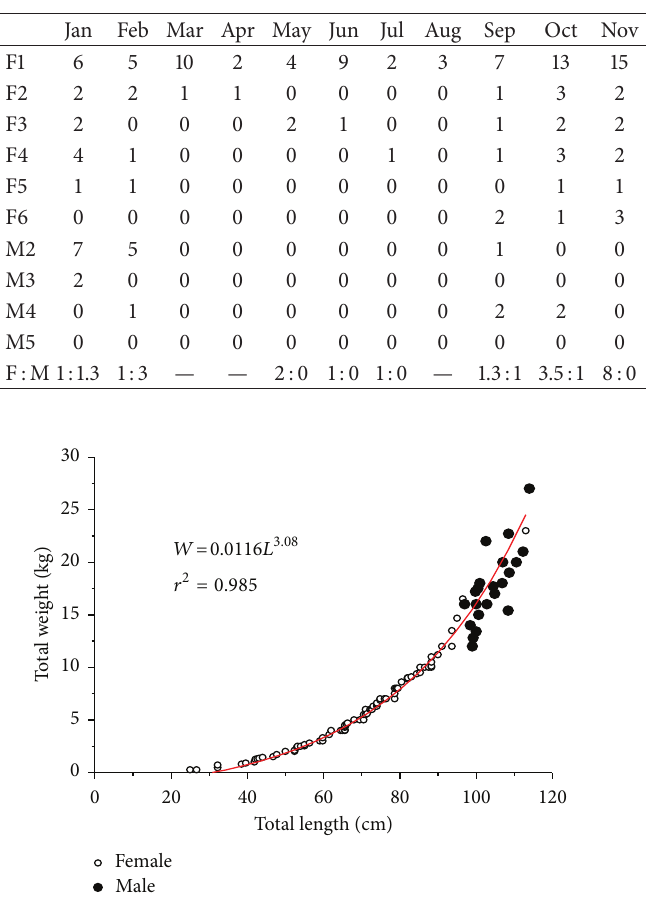
Figure 4: Length-weight relationship in Epinephelus malabaricus captured at Mafia Island between September 2009 and December 2010 ( 𝑁 = 172 ). Figure 5: Size frequency distribution of female and male Epineph- elus malabaricus ( 𝑁 = 172 ) collected from small scale fishers in Mafia Island between September 2009 and December